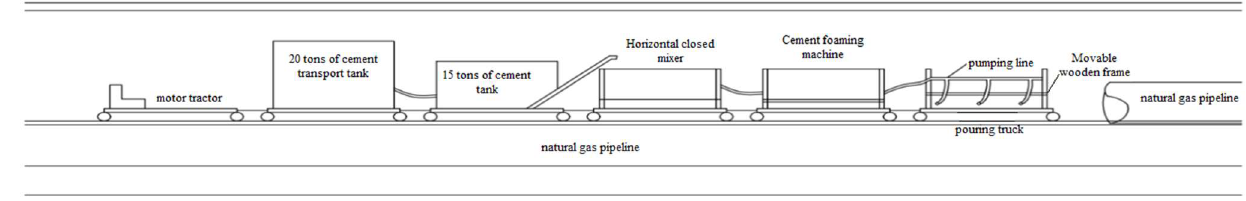
Figure 7. Schematic diagram of filling system for digital foamed-concrete production.